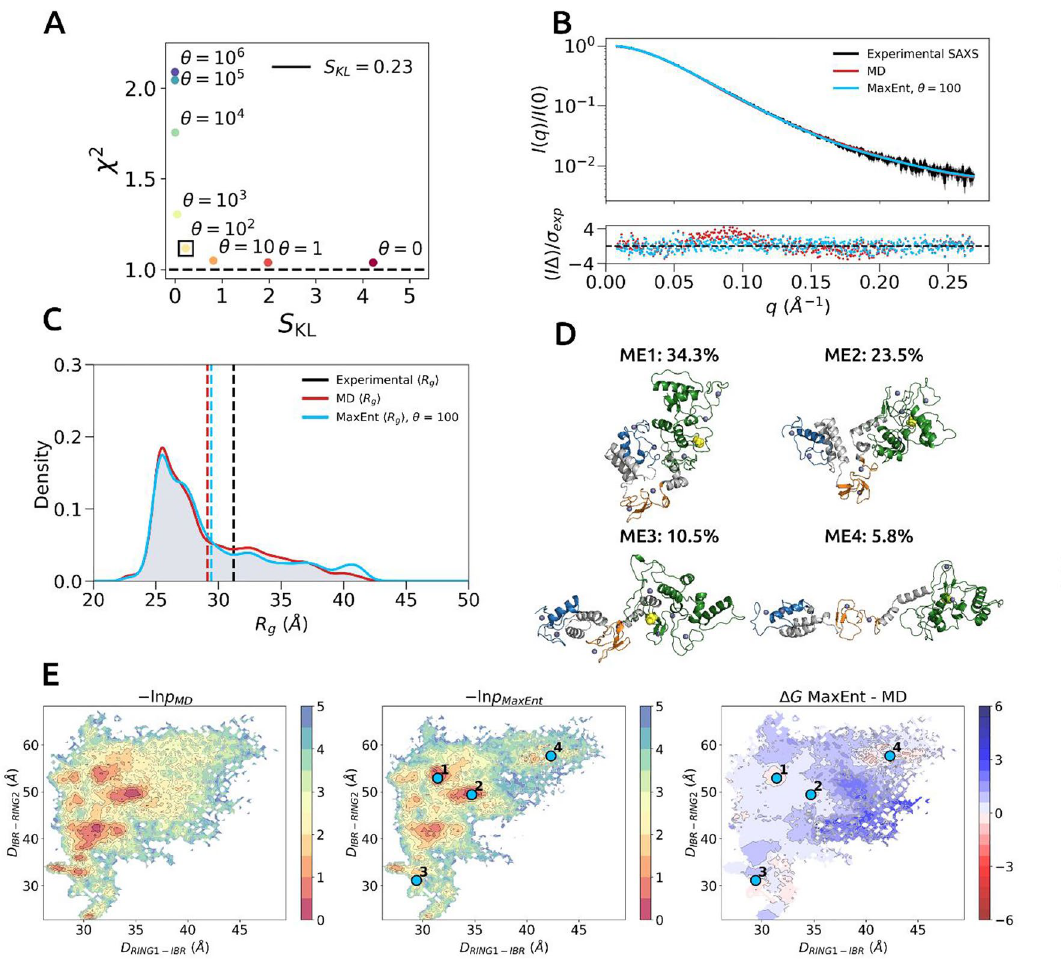
Figure 5. MaxEnt ensemble modelling of the HOIP RBR domain. ( A ) L-curve analysis for determining optimal value of the confidence parameter θ. The elbow of L-curve was selected as θ = 100 (black square). ( B ) Agreement between experimental and ensemble scattering profiles. The experimental, MD and MaxEnt scattering profiles are coloured black, red and cyan, respectively. The error-weighted residuals (I∆)/σ exp = [I exp (q) − I ensemble (q)]/σ exp versus q are plotted below. ( C ) Comparison between ensemble R g distributions. The average values are denoted as vertical dashed lines. ( D ) Top 4 conformers (ME1-4) after clustering of structures with optimized weights (θ = 100) above one standard deviation of the mean. Percentages represent proportion of significant conformers. Structures are coloured with respect to their RING1 (blue), IBR (orange) and RING2 (green) domains. The catalytic cysteine C885 is shown as yellow spheres. Zn +2 ions are shown as dark blue spheres. For an overlap of members in two different orientations see Supplementary Fig. 3C. ( E ) MaxEnt reweighing of relative free energy surface. Left-hand panel represents initial MD ensemble. Middle panel represents MaxEnt reweighing of the MD ensemble. Top 4 conformers of are mapped as cyan coloured points, respectively. The right-hand panel represents difference between MaxEnt and initial MD